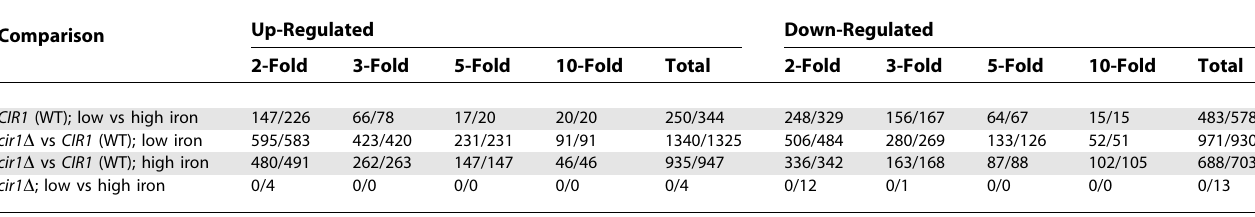
Table 1. Number of Genes Differentially Regulated by Iron Availability and/or Cir1 Comparison